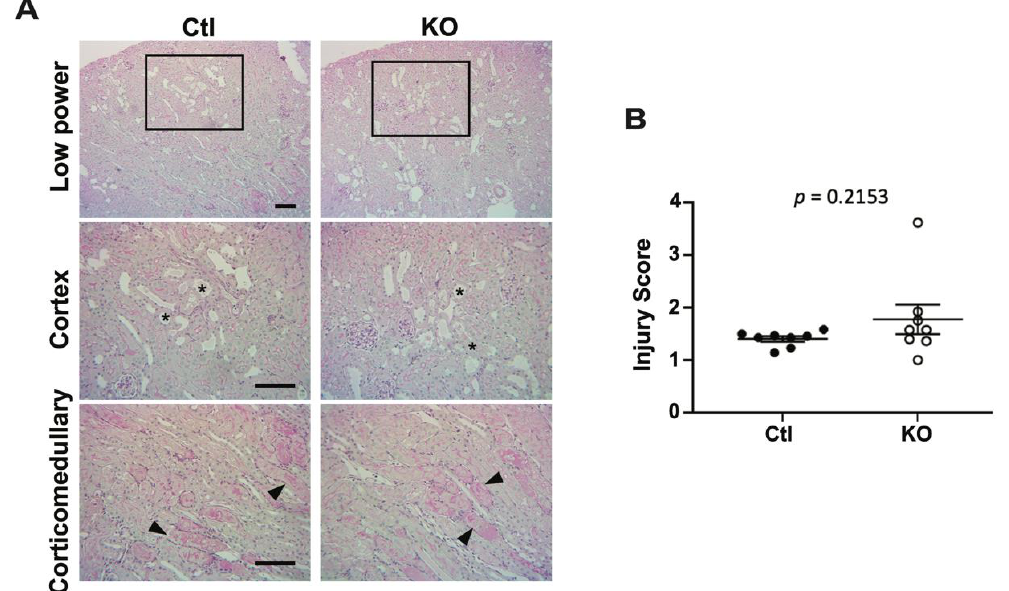
Figure 4. Histological examination reveals no difference in tubule injury. Kidney sections from control and knockout animals were stained with periodic acid-Schiff (PAS) to assess the extent of tubule injury with IRI. ( A ) Representative images from control and knockout injured kidneys reveal the presence of damaged tubules (top panels). The area indicated by the black box was enlarged (middle panels) to show the presence of dilated tubules with luminal casts (indicated by stars), and the corticomedullary region showed diffuse injury of tubules (indicated by arrowheads). ( B ) Sections were evaluated by an investigator blinded to animal group. No difference was observed in the extent of damage between injured kidneys from control and knockout animals, as analyzed by unpaired t-test. Uninjured kidneys were also analyzed, with no injury being observed in either genotype (images not shown). Bar denotes 100 µm.